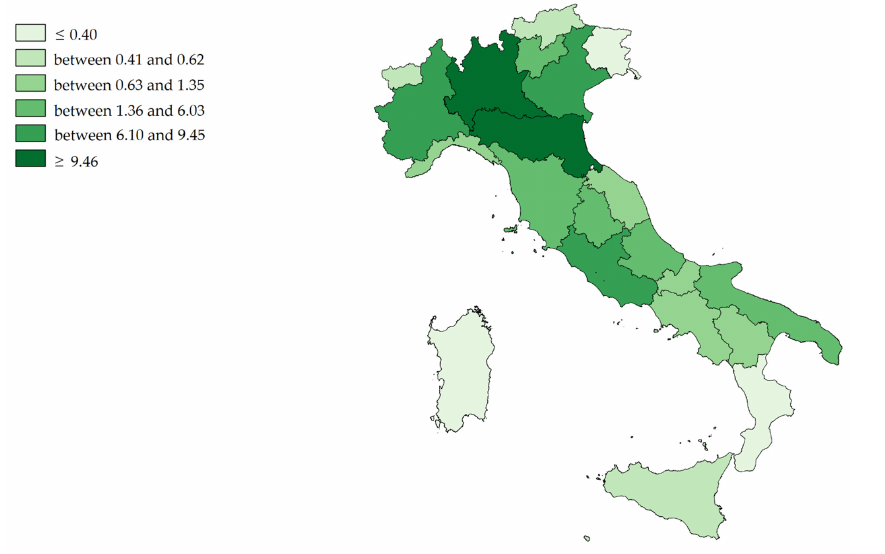
Figure 4. Cartographic representation of Attraction Absorption Indexes (AAI) for hospital orthopedic intensive rehabilitation, mean from 2011 to 2019.